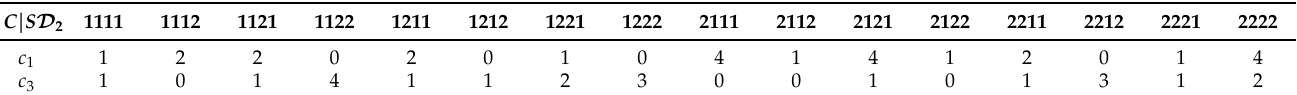
Table 2. Payoff Matrix of G